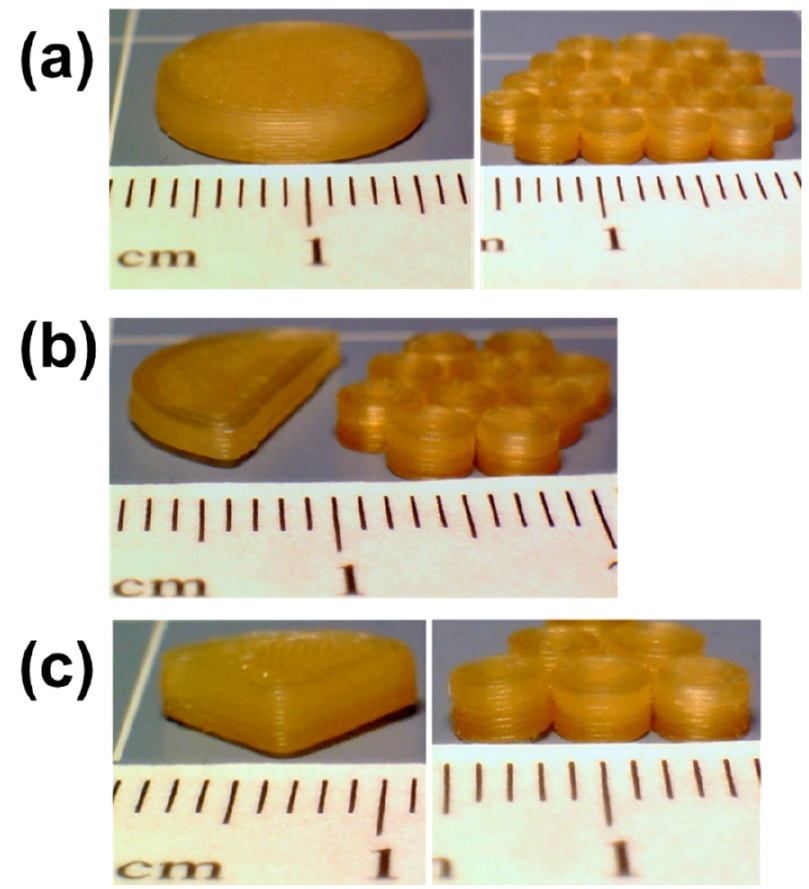
Figure 1. Digital images of ( a ) full tablet vs. twenty units mini-tablets, ( b ) half tablet vs. ten units mini-tablets, and ( c ) quarter tablet vs. five units mini-tablets, each sub case contains similar drug amounts (all the tablets were printed using the formulation F1 listed in Table 1).